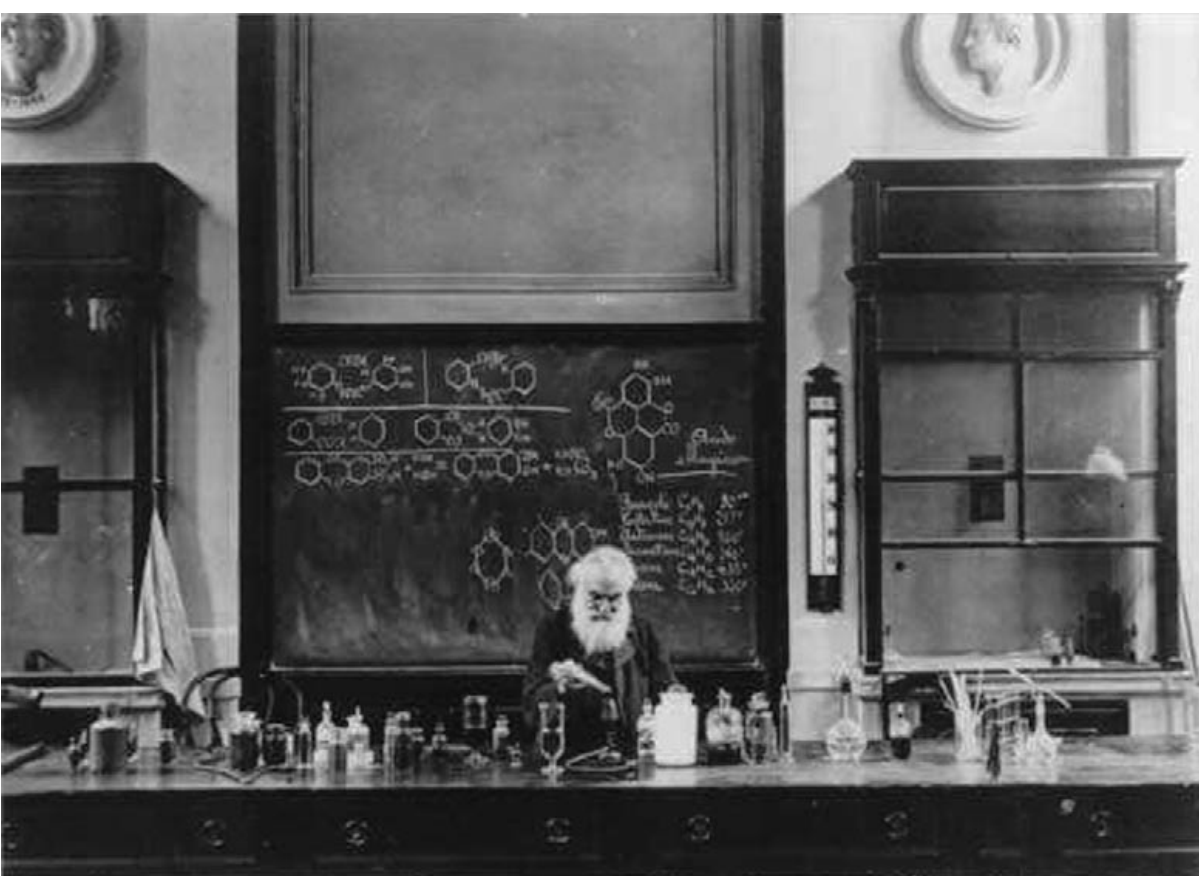
Figure 3. Hugo Schiff, 24 April